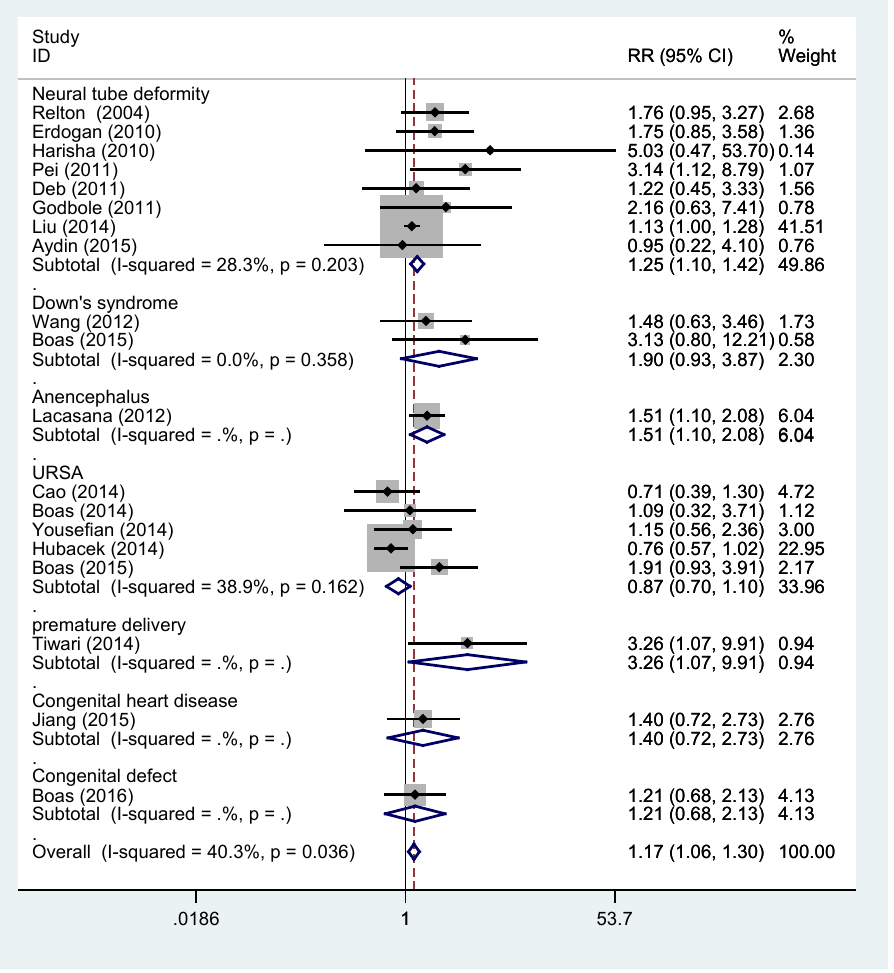
Figure 3: Forest plot of the methylenetetrahydrofolate reductase gene 677C > T polymorphism and fetal congenital defects in a homozygous genetic